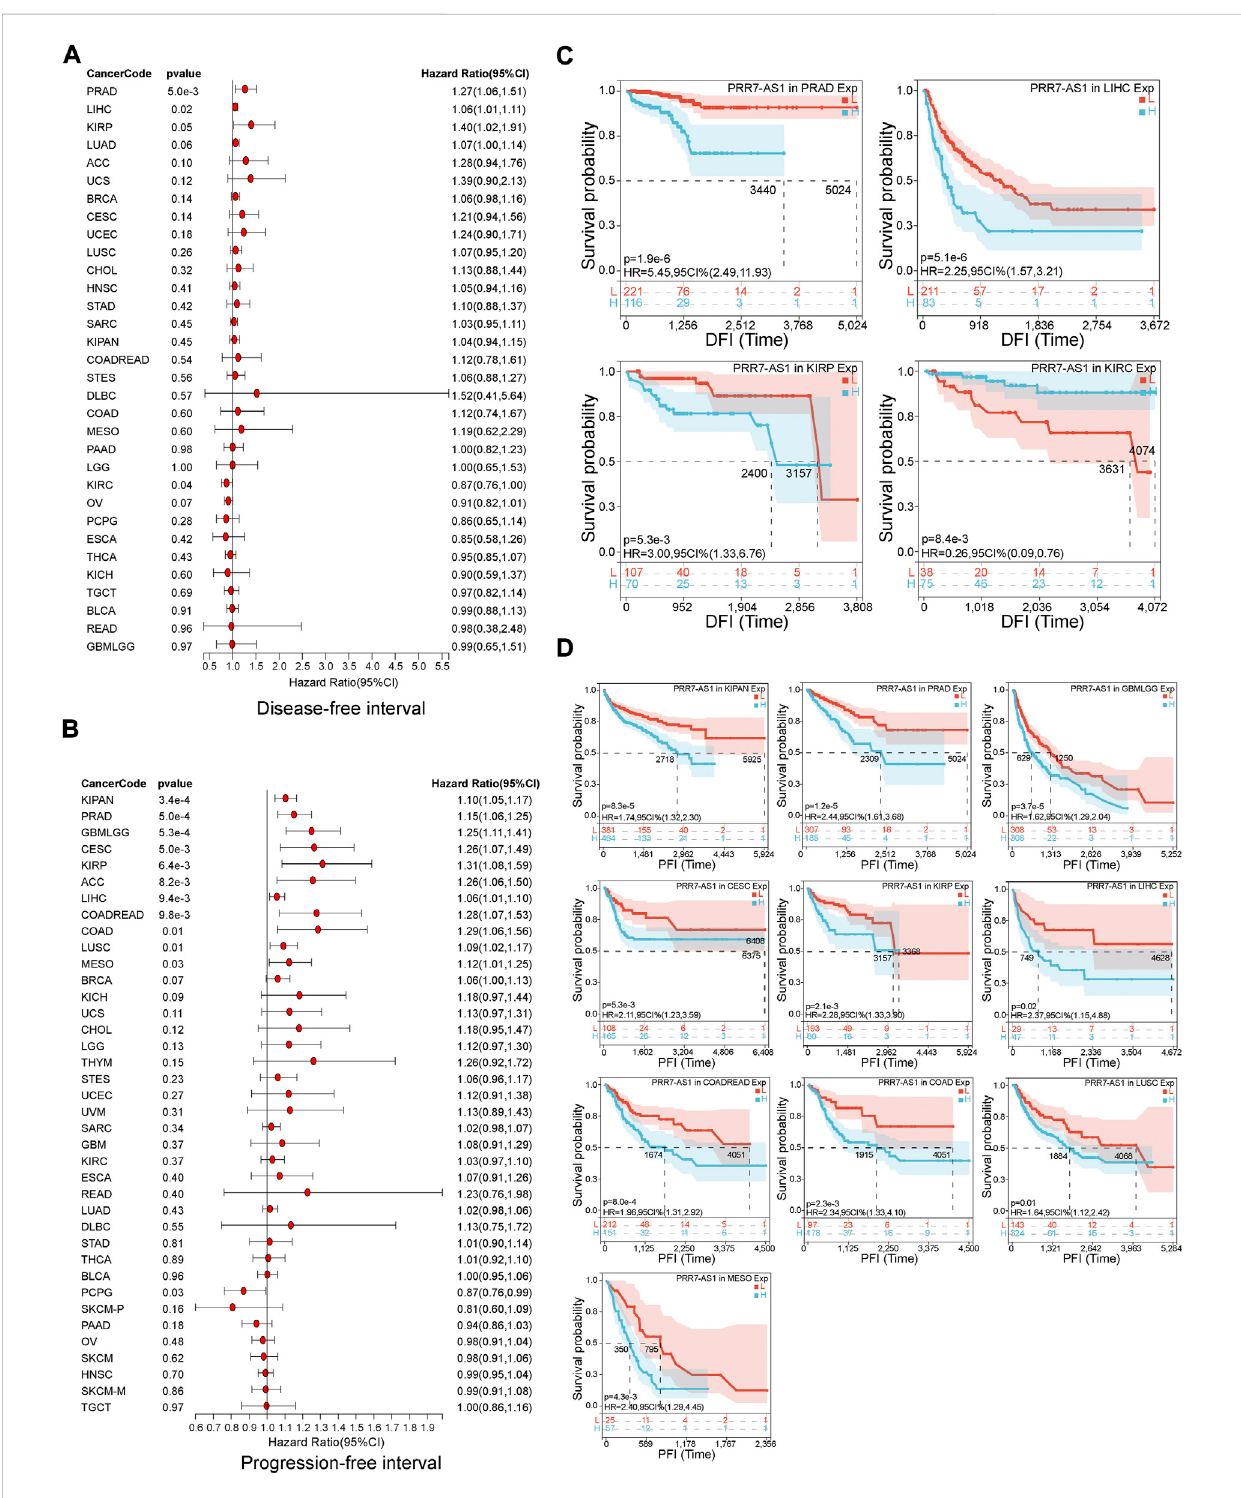
PrognosticvalueofPRR7-AS1fordisease-freesurvival(DFI)andprogression-freeinterval(PFI)inpan-cancer.Theforestplotsshowingtheresultsof Cox regression analysis for (A) DFI and (B) PFI. Kaplan-Meier analysis of (C) DFI and (D) PFI for PRR7-AS1 in different